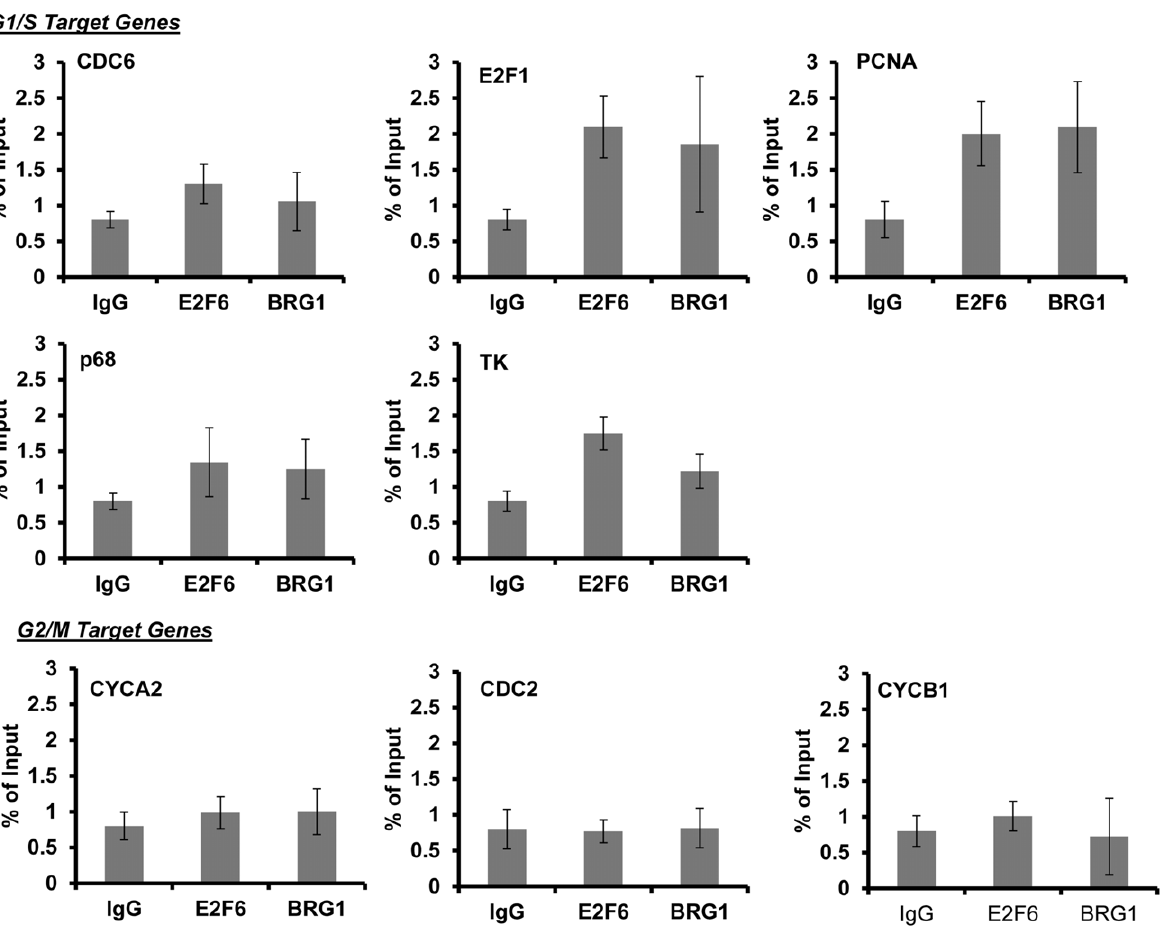
Figure 4. Chromatin immunoprecipitaion of E2F6 and BRG1 on G1/S and G2/M promoters. E2F6 and BRG1 bind to G1/S promoters but not G2/M promoters. Cells were synchronized by serum deprivation and then collected at 24 hours following serum stimulation. Chromatin immunoprecipitation was performed with antibodies to E2F6 and BRG1. A rabbit IgG was used as a negative control. Enrichment for G1/S and G2M promoters were assessed by quantitative PCR using SYBR Green.